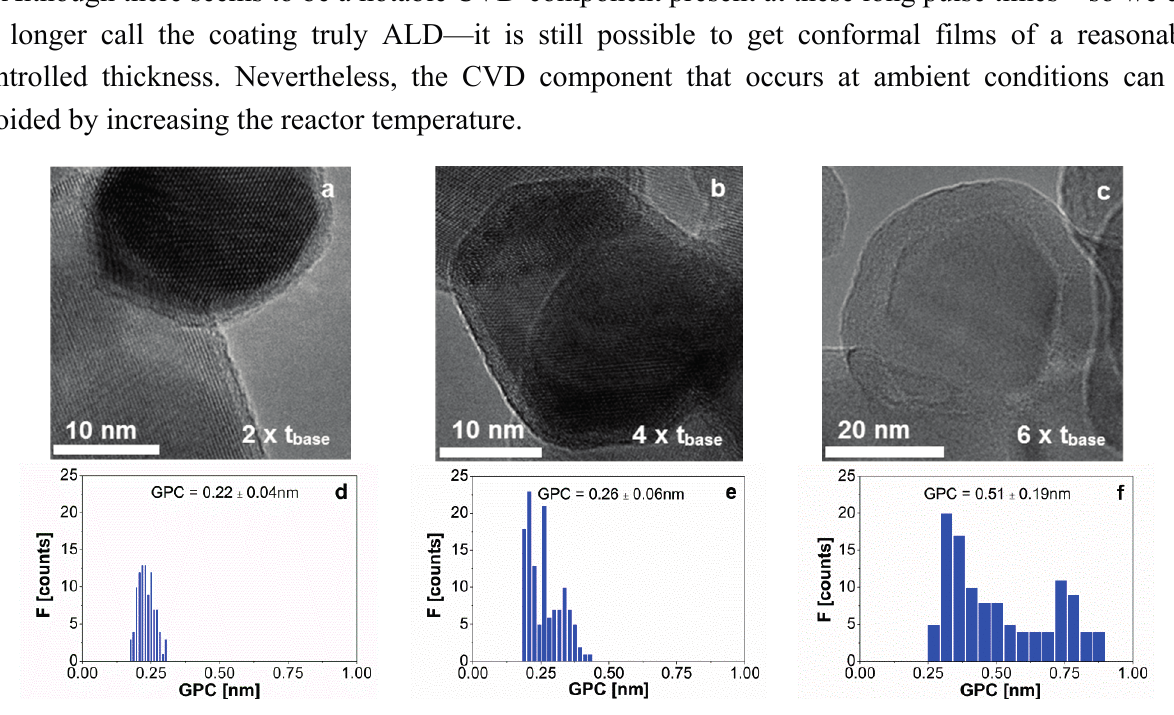
Figure 3. TEM image of the alumina film on TiO 2 nanoparticles after 7 cycles when the dosing time of TMA per cycle is ( a ) 7 min; ( b ) 14 min; and ( c ) 21 min. The distribution of the GPC obtained from TEM images for a dosing time of TMA of ( d ) 7 min; ( e ) 14 min; and ( f ) 21 min. The mean and standard deviation values are shown in each